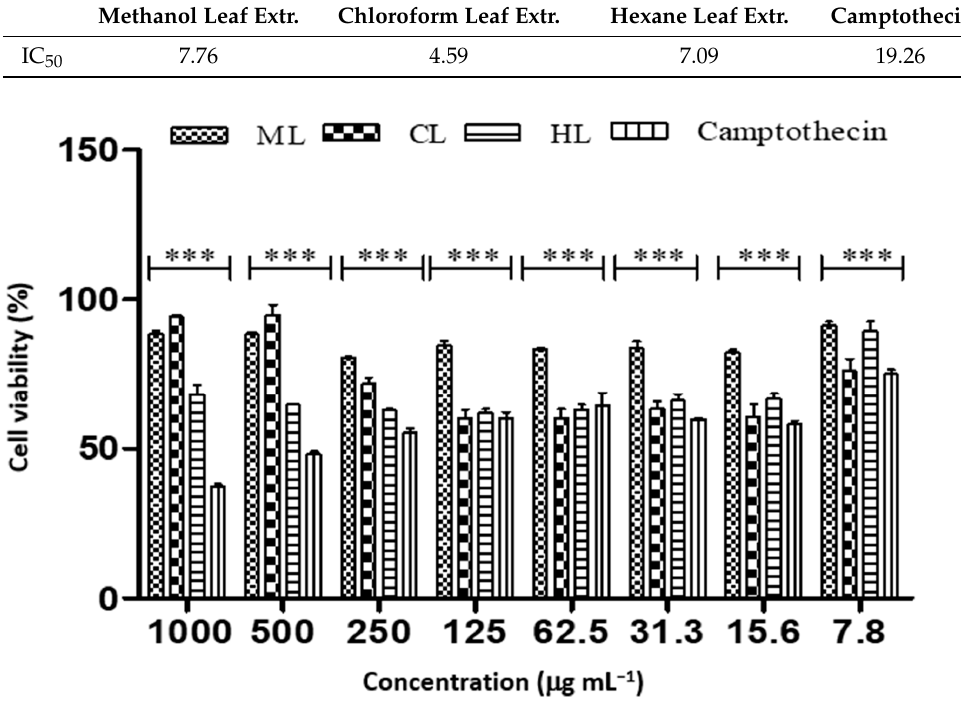
Table 10. IC 50 values of methanol, chloroform and hexane extract of D. villosa stem against A549 ceFll.